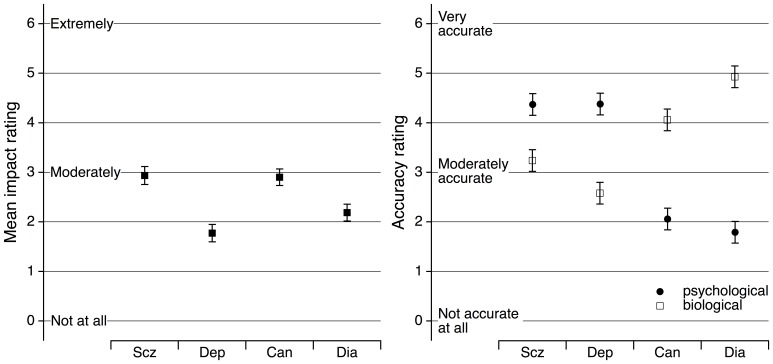
Impact and accuracy ratings obtained in Study 1.Left panel. Mean item rating for anticipated adverse impact of news of risk about schizophrenia (Scz), depression (Dep), cancer (Can), and diabetes (Dia). Right panel. Mean ratings of the perceived accuracy of psychological and biological screening for the four disorders. All error bars represent 95% confidence intervals.